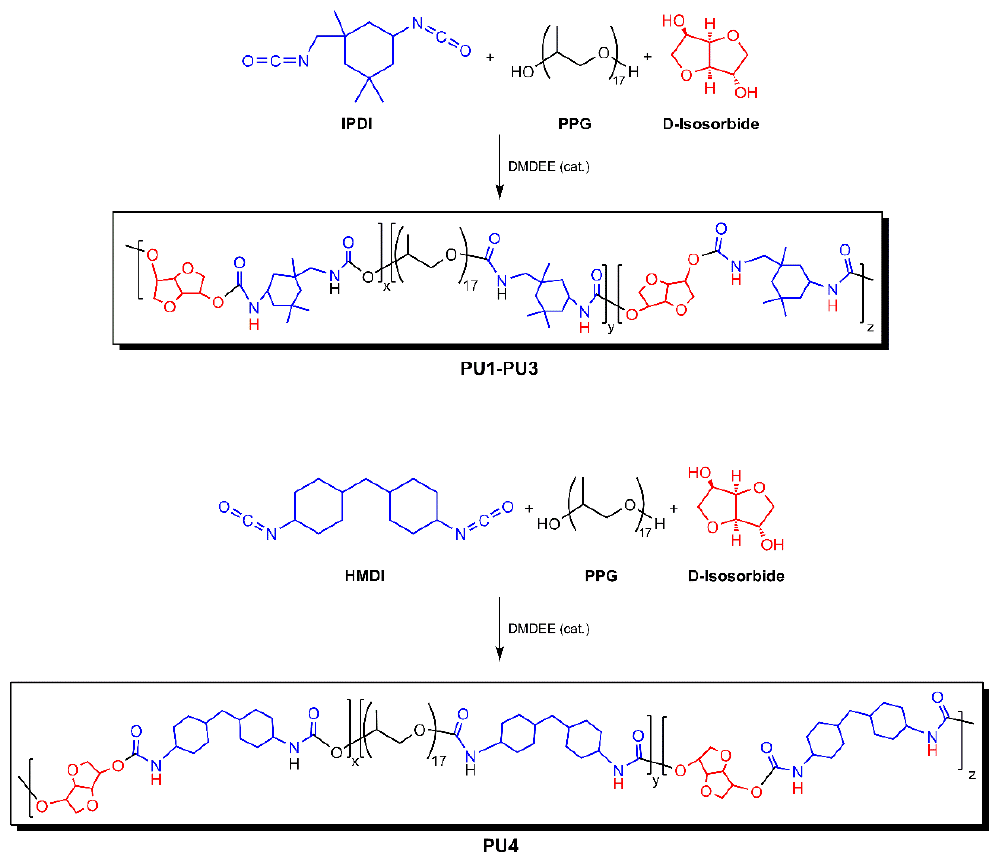
Figure 2. The synthesis of polyurethanes PU1 – PU4 .